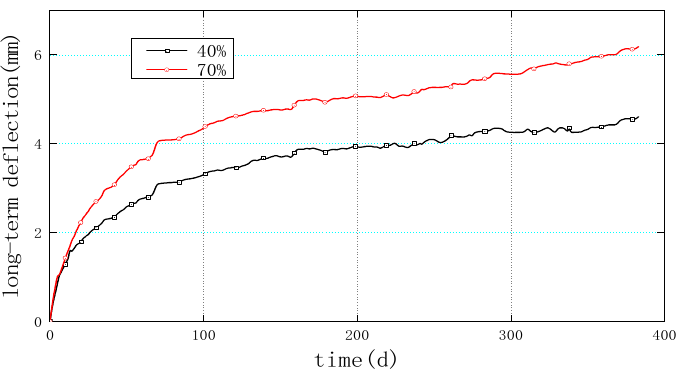
Figure 16. Evolution of the long ‐ term deflection of concrete T ‐ beam specimens for two load levels (loading age of 7 days).